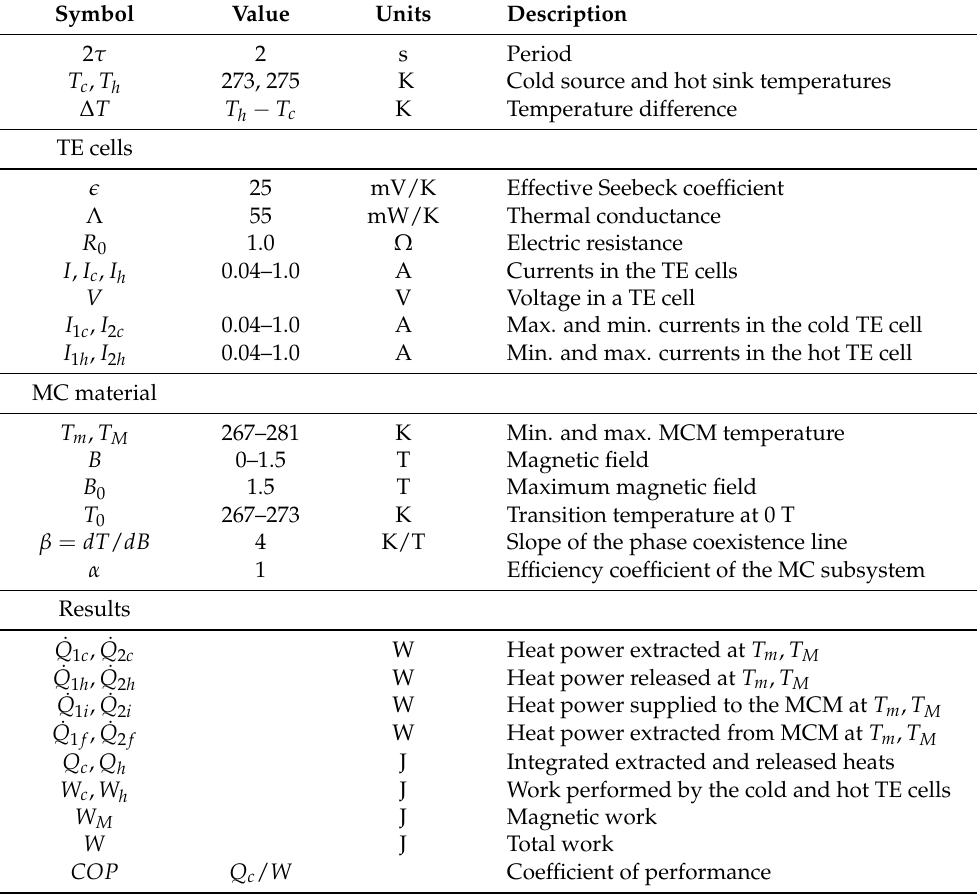
Table 1. Typical parameters used in the calculation for a TE-MC sandwich with an ideal MCM working in the phase coexistence region. The TE cells used are model 1ML07-050-15AN25 from RMT Ltd. Symbol Value